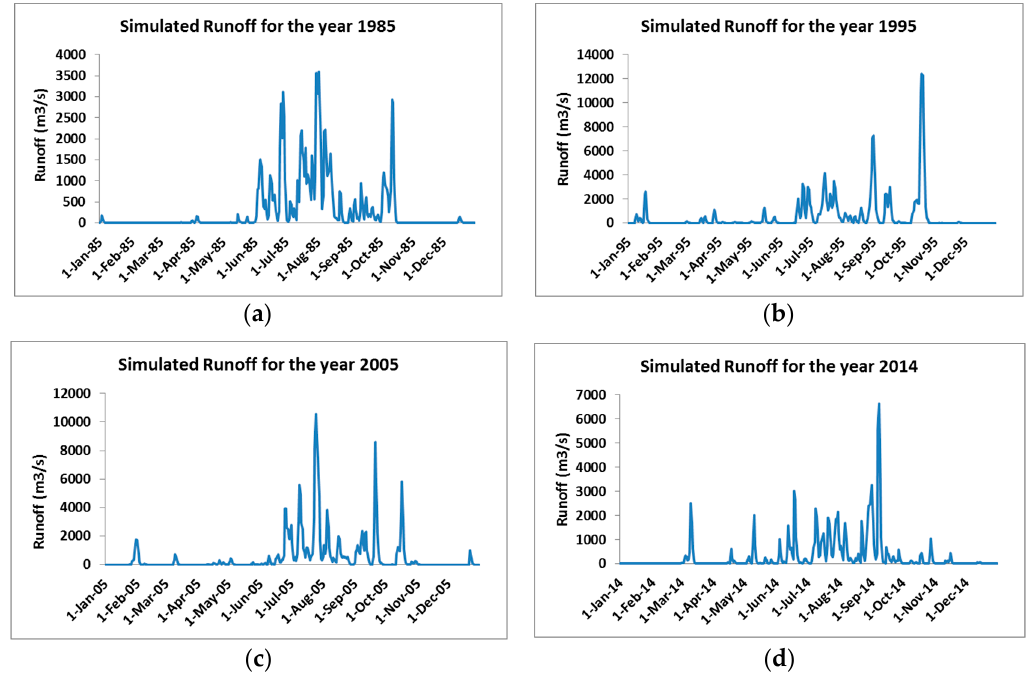
Figure 9. Simulated and observed discharge graph. 5.4. Impact of LULC Change on Runoff Rainfall is the most important parameter that influences all of the water balance components such as runoff. The total rainfall in the Godavari Basin for the years 1985, 1995, 2005, and 2014 were 928 mm, 1372 mm, 908 mm, and 1474 mm, respectively. The year 1995 had the highest recorded rainfall, and these values are highly correlated with the rainfall. The runoff value depends on the rainfall. The LULC change analysis was carried out for all the watersheds for the years 1985, 1995, 2005, and 2014 and the Pranhita watershed was found to have undergone the major LULC change in terms of decrease in forest cover; decrease in shrubland; increase in built-up land, increase in cropland; increase in fallow land; increase in water bodies; and increase in barren land (Table 8). Hence, we have considered the Pranhita watershed to study the effect of LULC change on the runoff. Simulation for the runoff in the Pranhita watershed was carried out for the years 1985, 1995, 2005, and 2014. Figure 10 shows the distribution of runoff for 1985, 1995, 2005, and 2014 for the Pranhita watershed. The trend of runoff was found to be highly dependable on the amount of rainfall received in the entire basin. The yearly trend of rainfall during 1985 was found to be much less than the other years, and the runoff was also found to follow the same trend (Figures 2 and 10). Similarly, for the year 1995, the runoff was recorded as high, which was mainly due to that year also having the highest rainfall. A decrease in the runoff was observed from 1995 to 2005, which may have been due to the reverse trend in the land-cover conversions and/or human activities. In summary, a decrease in the natural cover of the forest over a period of time caused a significant rise in the surface runoff. The surface runoff increases were due to the decrease in infiltration, and hence groundwater recharge processes. The increase in built-up, which was due to urban expansion and intensive cultivation (increase in cropland), will loosen the soil, leading to soil erosion, as well as a decrease in the surface